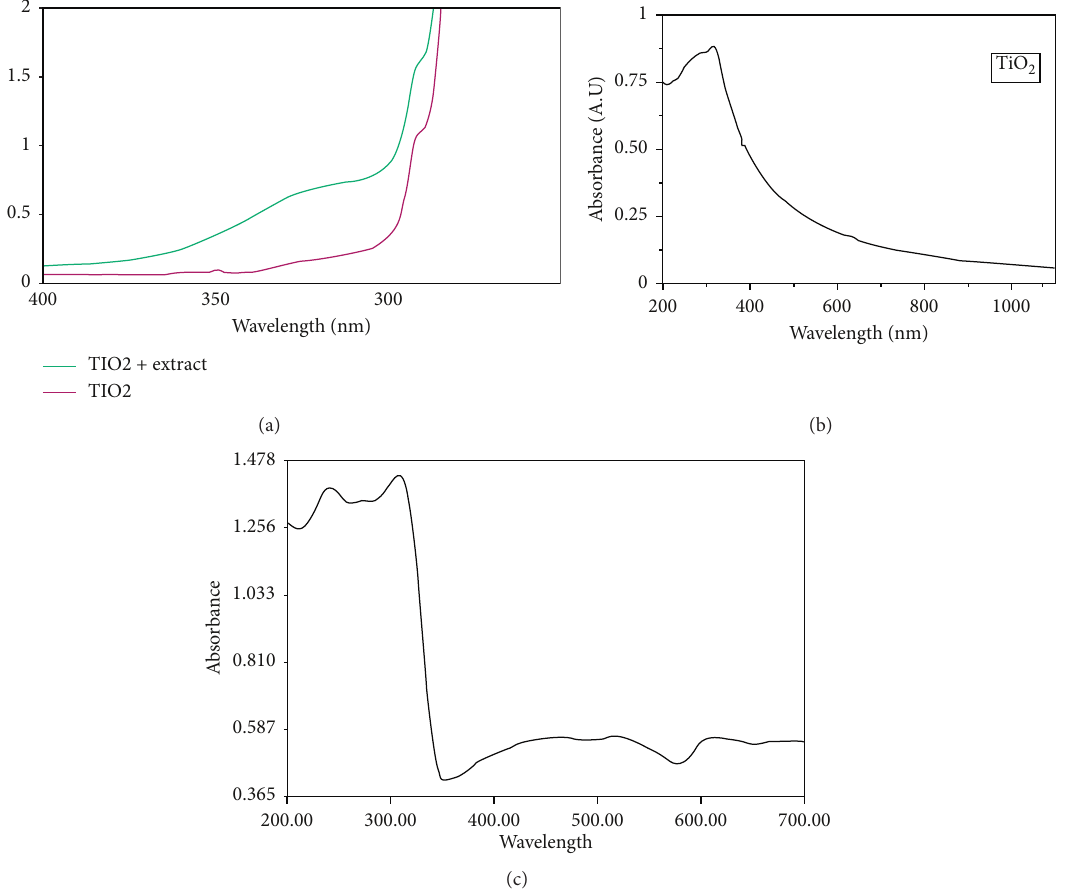
Figure 6: UV-Vis absorption spectra of (a) Echinacea purpurea herba -, (b) Hibiscus flower-, and (c) Aloe vera -extract-mediated synthesized TiO 2 NPs [68, 69,